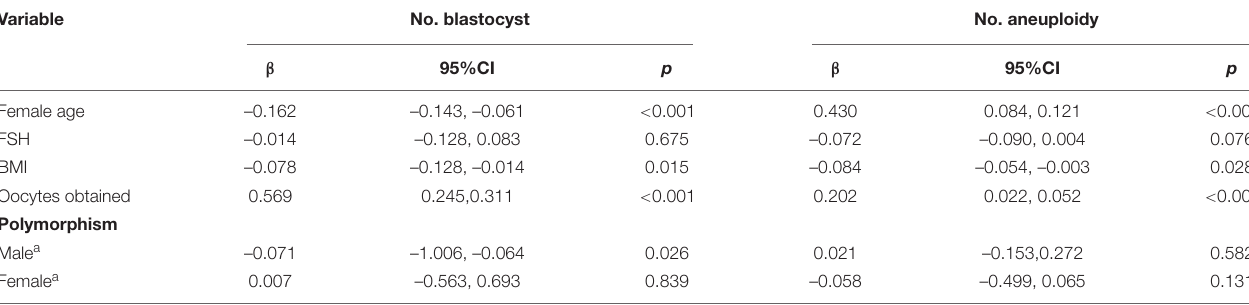
TABLE 4 | Multiple linear regression for the number of blastocyst and aneuploidy in uRPL couples.